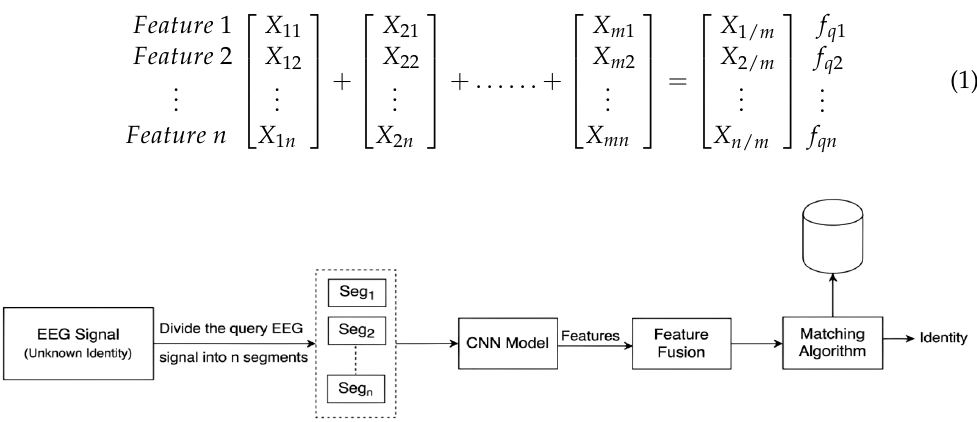
Figure 2. Identification System.